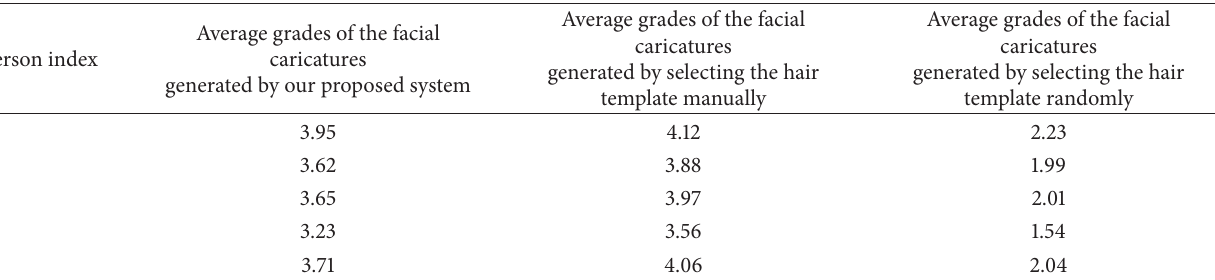
Table 7: Grading results by 5